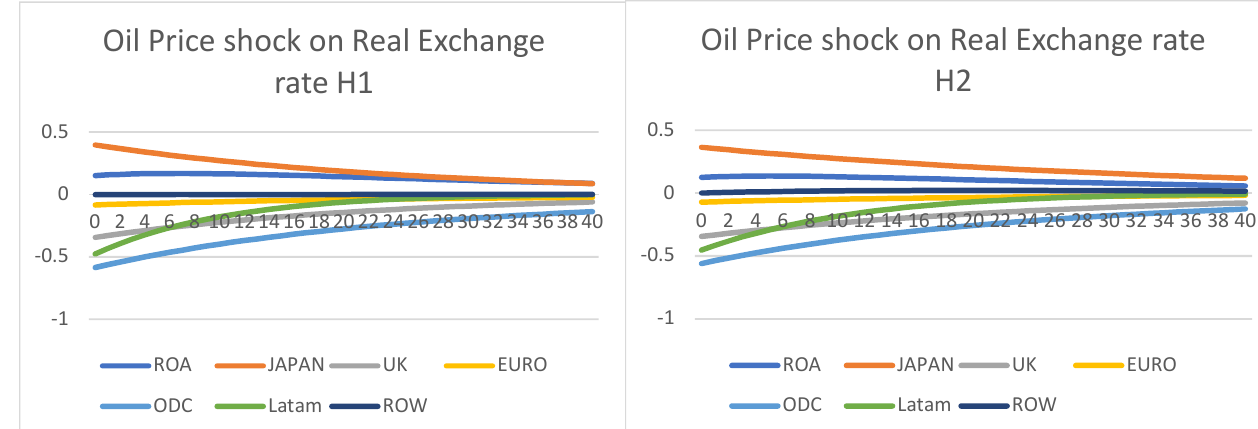
Figure 2. Positive oil price shock on real exchange rates. US monetary shock on inflation—Figure 3